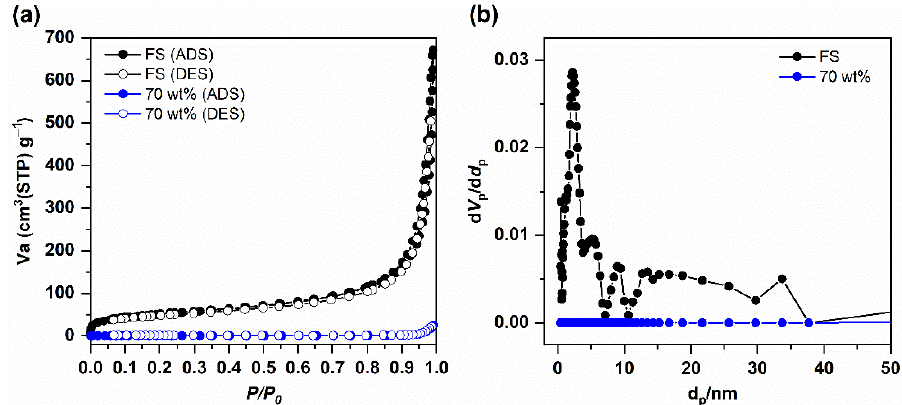
Figure 3. ( a ) N 2 sorption isotherms of FS and the 70 wt% composite, and ( b ) pore size distributions of FS and the 70 wt% composite.